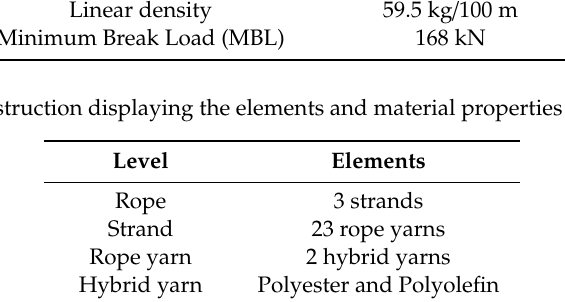
Table 1. Rope parameters provided by the manufacturer.